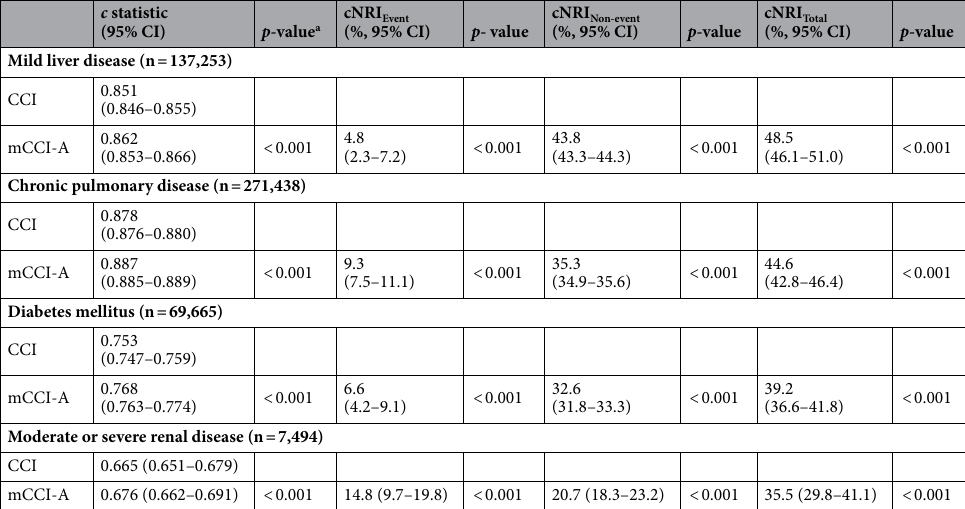
Table 5. Model performance of the mCCI-A in the subgroup analysis with specific disease. cNRI, continuous net reclassification improvement; CCI, Charlson Comorbidity Index; mCCI-A, modified version of the Charlson Comorbidity Index for Asian populations; cNRI Total = cNRI Event + cNRI Non-event . All models were adjusted for age (quartile), sex, region and family income ratio (11 groups). a p -value for the c statistic was taken and computed for a contrast